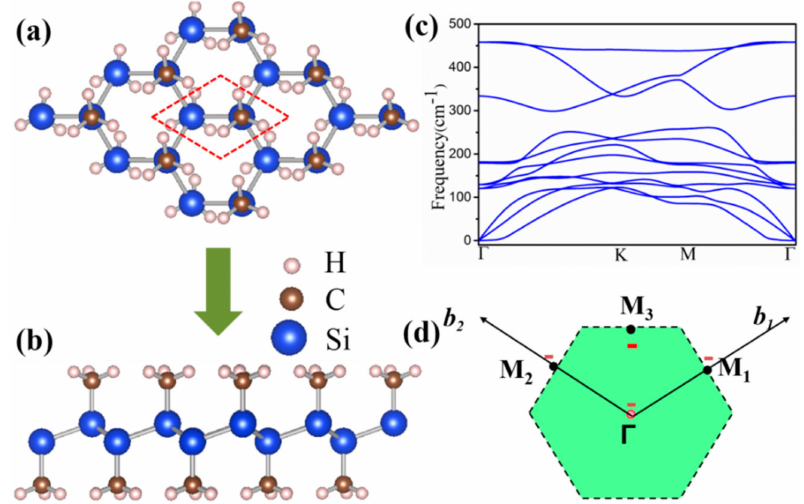
Figure 1. ( a ) Top and ( b ) side views of the schematic structures of silicene (SiCH 3 ) monolayer;